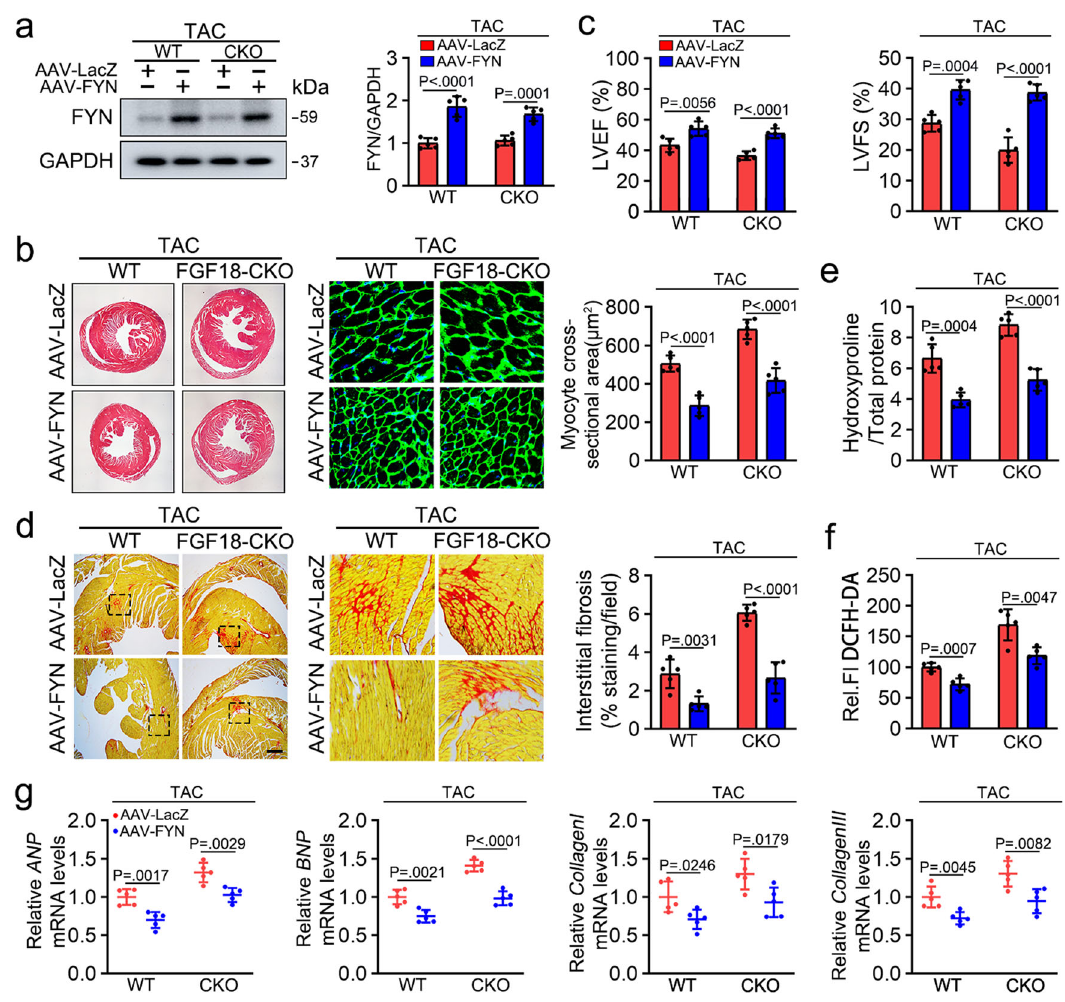
Fig. 7 | Cardiac FYN overexpression partially rescues PO-induced cardiac hypertrophy in Fgf18-CKO mice. Fgf18 f/f and Fgf18 - CKO mice ( α MHC-MerCreMer; Fgf18 f/f ) were intraperitoneally injected with tamoxifen at 6 weeks old male mice. FYN overexpression adeno-associated virus (AAV9-cTnT-FYN) and control vector (AAV9-LacZ) were injected intravenously into tail veins of 6 weeks old male mice. Two weeks after the injection, these mice were subjected to TAC operation. a Validation of overexpression of FYN by western blot. Quanti fi cation of relative proteinlevels(rightpanel). n =5. b HistologicalanalysisoftheHEstainingandWGA staining ( n =5. Scale bar=0.6mm for left HE staining; scale bar=20 μ m for right